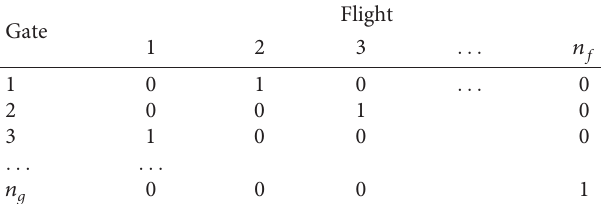
Table 1: The solution form of the gate assignment problem. Gate